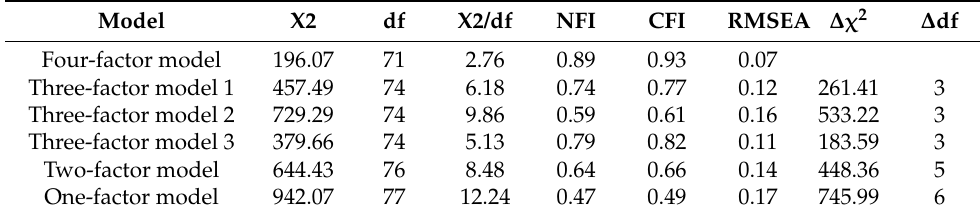
Table 2. Results of the confirmatory factor analysis.